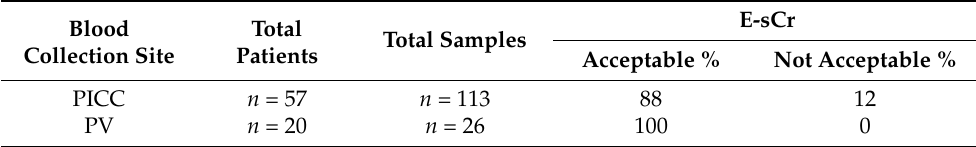
Table 1. Comparison of peripherally inserted central catheter (PICC) line and peripheral vein